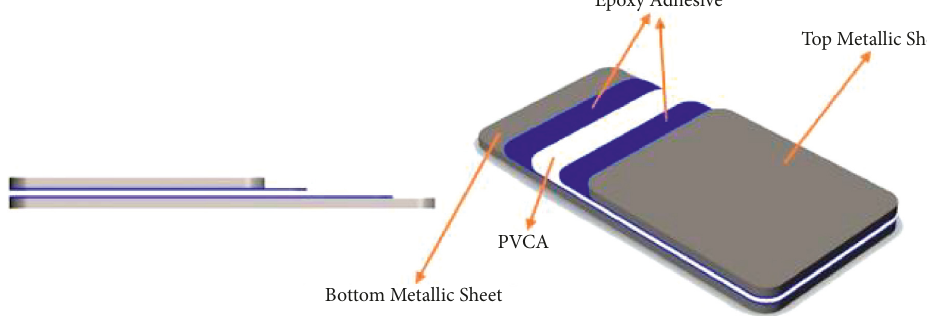
Figure 1: Schematic of MPM sandwich